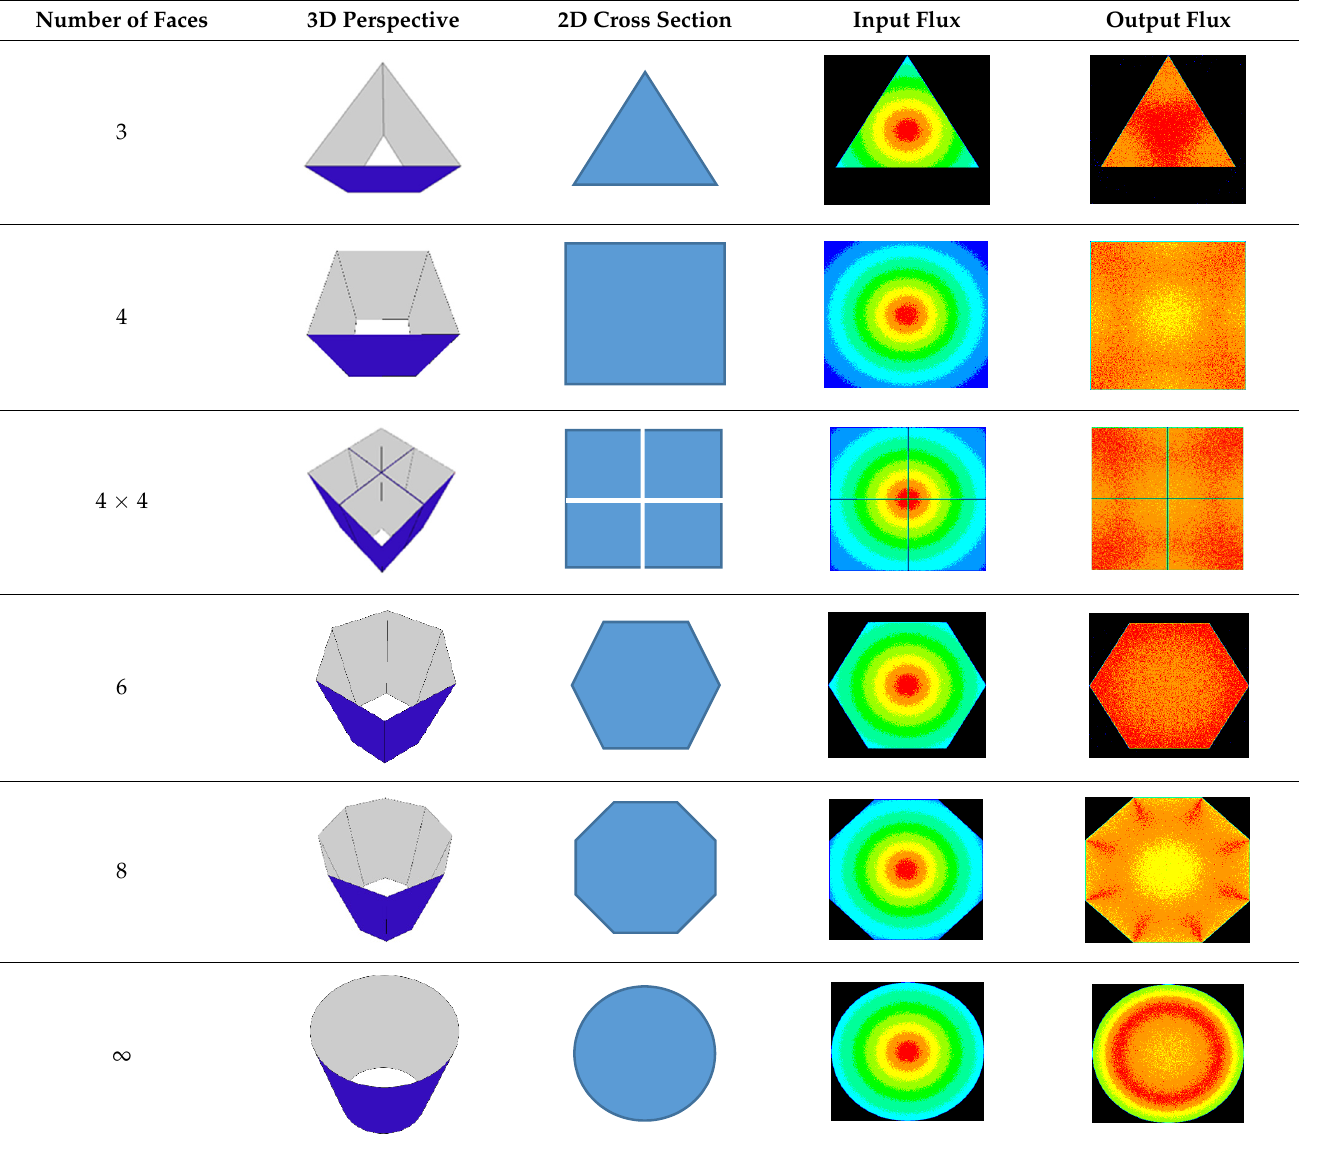
Table 3. Radiation flux at homogenizer entrance and exit, as a function of the number of faces, for the following conditions: Total length = 350 mm; position = 0 (centered at the theoretical focal point), tilt angle = 0 ◦ .